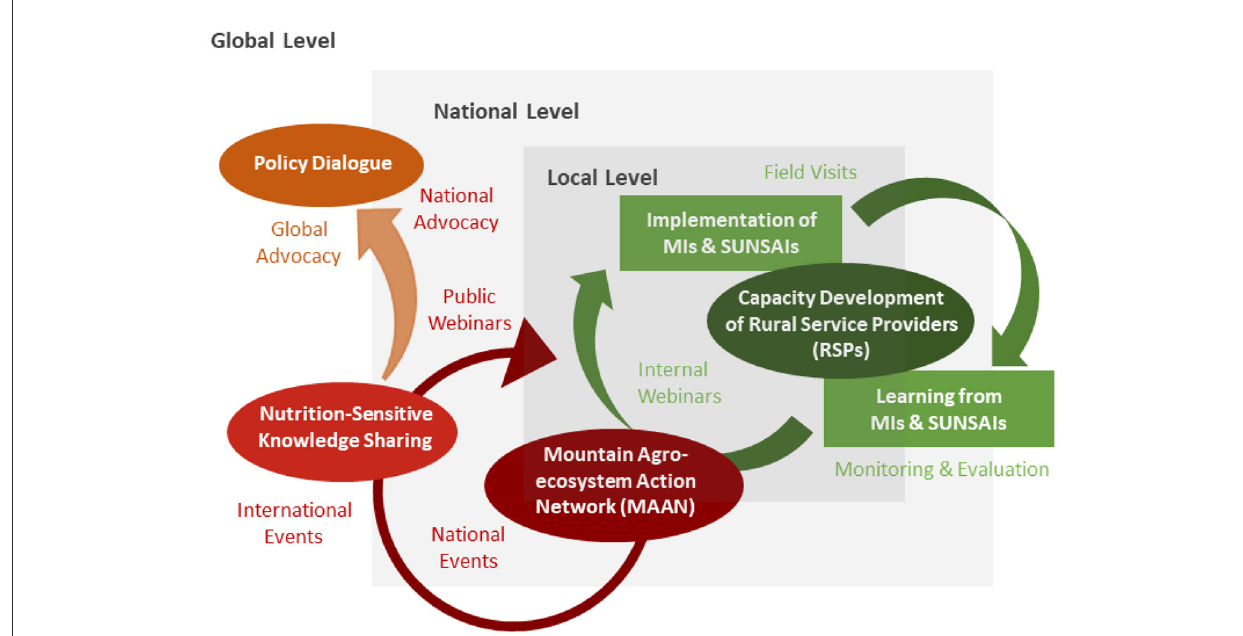
FIGURE1 Overall NMA project approach building on differentiated interventions at the local, national, and global levels, showing the central role of capacity development of rural service providers (RSPs) to catalyze outcomes and impact; adapted from Bernet et al. (2018).